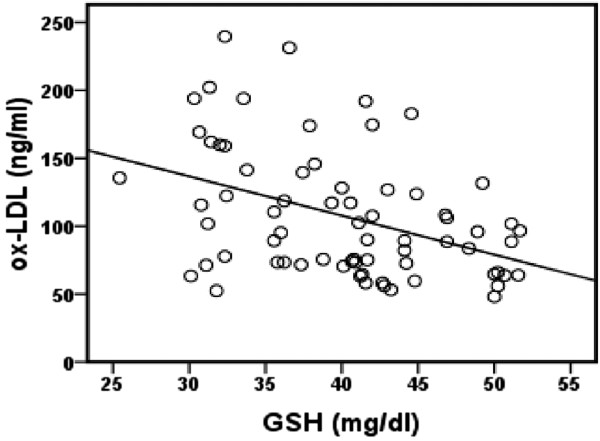
Correlation between GSH and ox-LDL levels in T2DM patients (r = − 0.412, p = 0.00039, n =70).